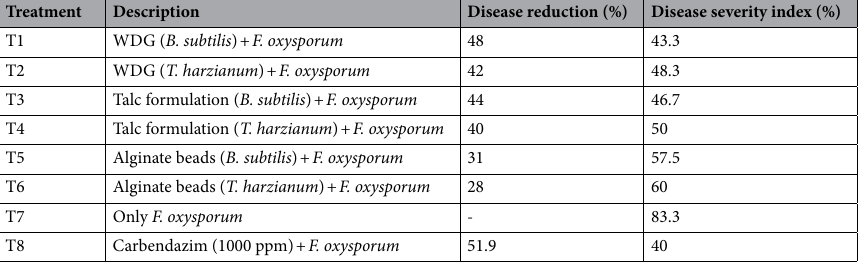
Table 2. Antifungal spectrum of microbial formulations in in planta assay under natural conditions to control Fusarium wilt in Solanum lycopersicum. n = 9; WDG = water dispersible